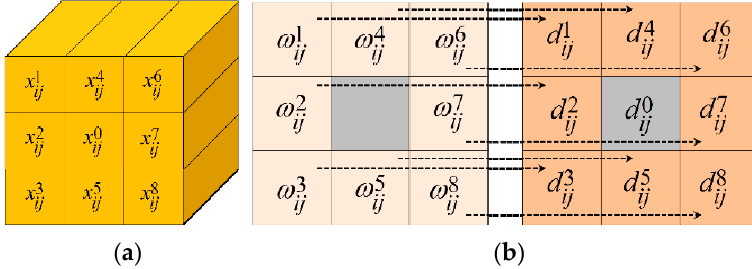
Figure 2. An illustration of the proposed Spectral-Spatial (SS) regularization, with: ( a ) W × W neighborhood centered by pixel x ij ( x 0 1, 2, i = 1, 2, · · · , I , j = 1, 2, · · · , J , w = 0, 1, · · · , W 2 − 1 and W =